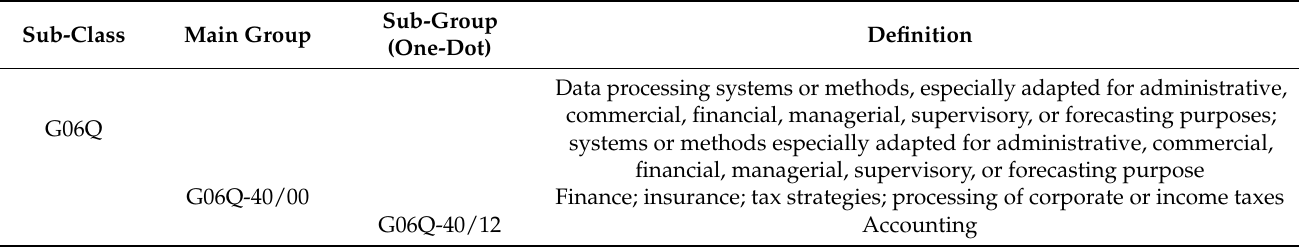
Table 1. Cooperative Patent Classification (CPC) for accounting (information